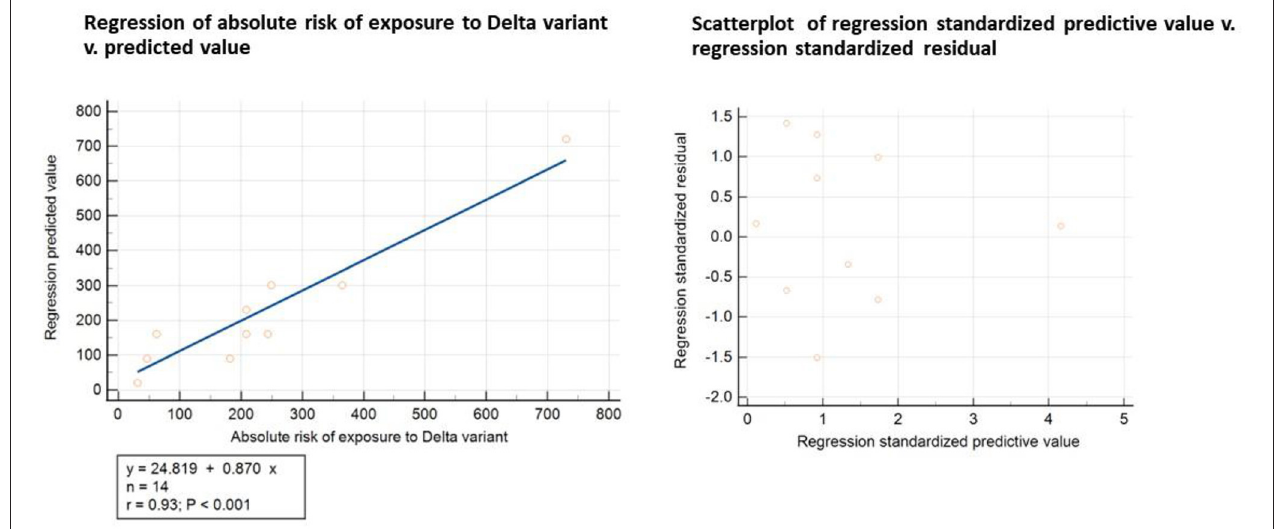
FIGURE 2 | Statistical test of the accuracy of the risk of exposure